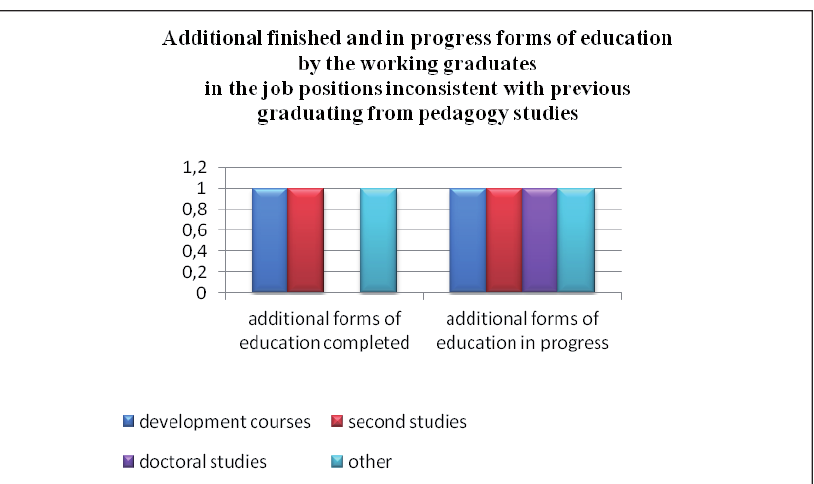
Fig. 6. Additional forms of education fi nished and already taken by the pedagogy gradu- ates working in the occupations inconsistent with their studies in the fi eld of